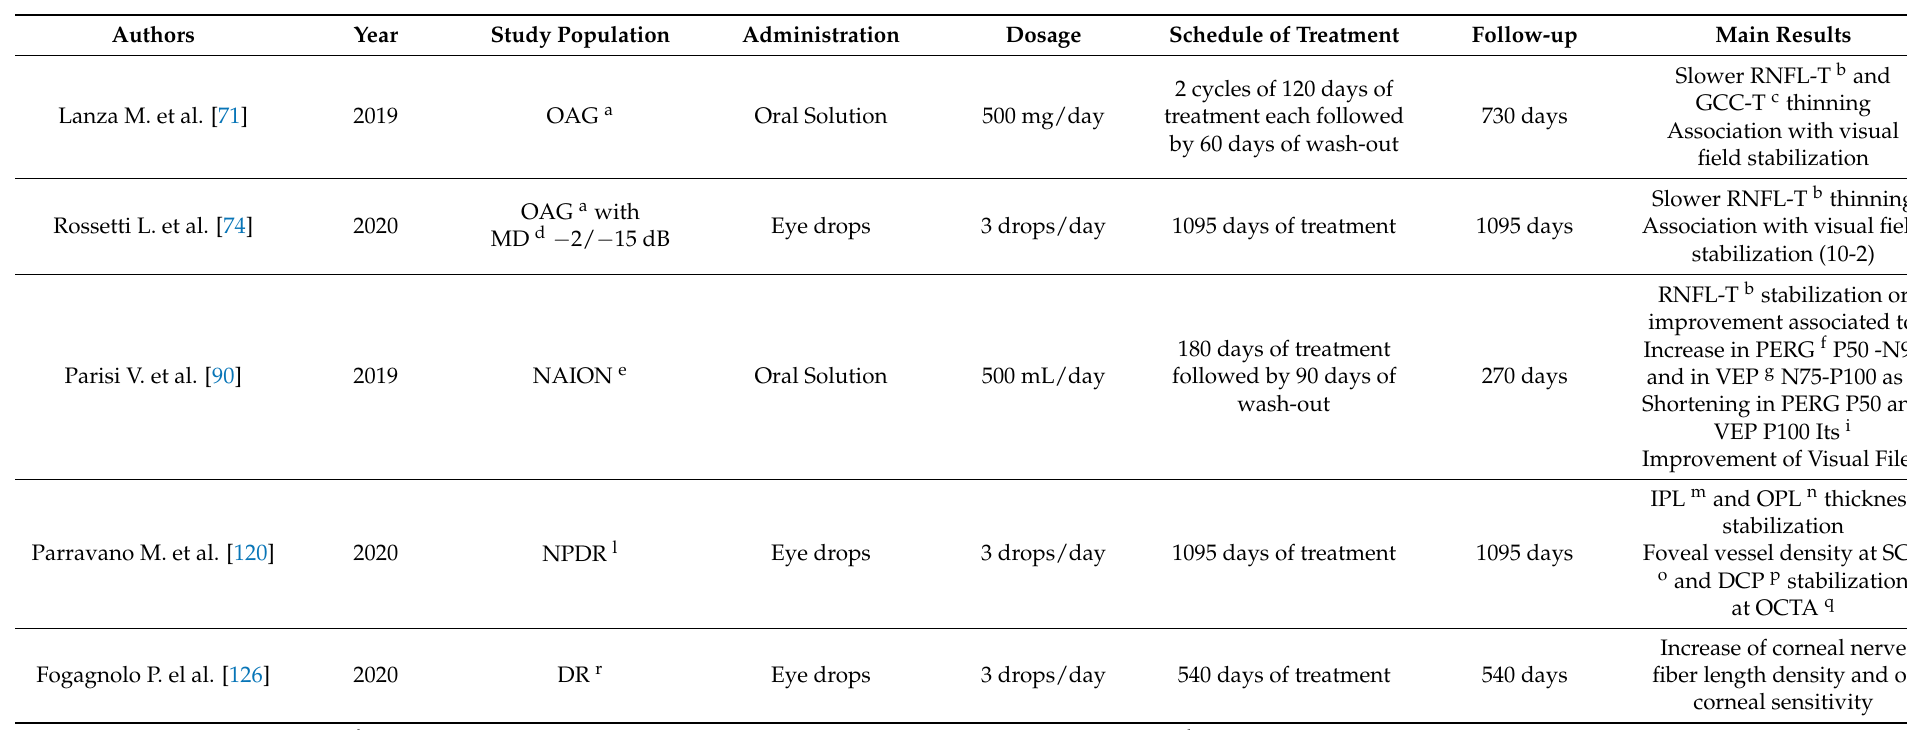
Table 4. Summary of clinical studies evaluating the effects of Citicoline in human ophthalmological neurodegenerative disease: morphological